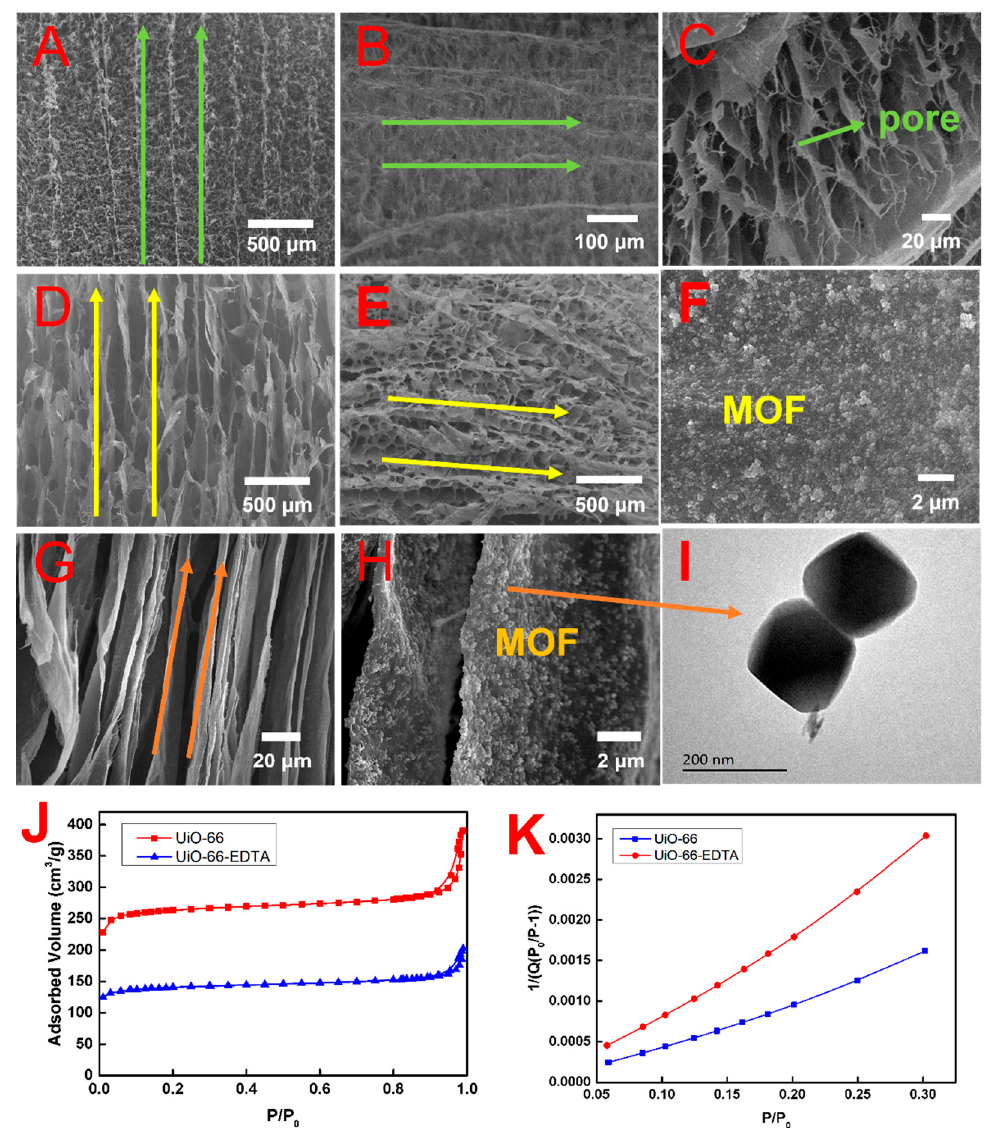
Figure 3. ( A , D , G ) FE-SEM images of the direction of ice; ( B , E ) FE-SEM images of the top view of the U -EDTA CCAs; ( C ) pore structure of U -EDTA CCAs; ( F , H ) FE-SEM images of UiO-66-EDTA particles loaded onto the “walls” of aerogels; ( I ) TEM images of UiO-66-EDTA; ( J , K ) N 2 adsorption/desorption isotherms and BET surface area plots of UiO-66 and UiO-66-EDTA at 77K, respectively.